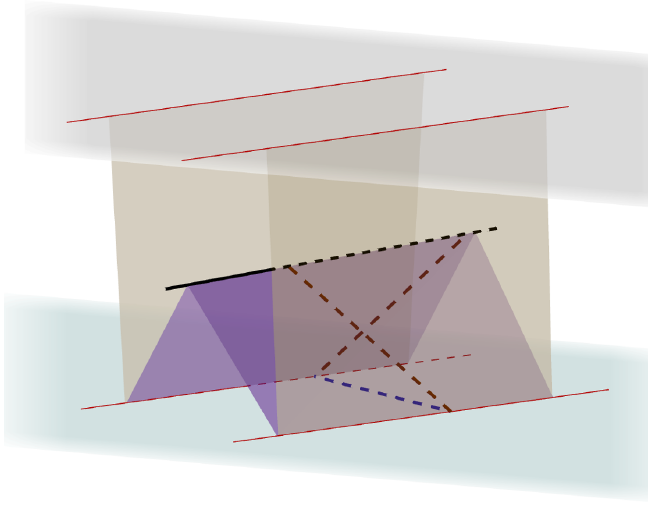
Figure 9 . The relative location of the pre-entanglement wedge W E [ A ] (bounded by two purple surfaces) and the causal wedge W [ A ] (bounded by two yellow surfaces) for (blue) single boundary C interval in planar BTZ spacetime. Two red lines on the (gray) black hole horizon are the intersection of the horizon and the yellow surfaces. Obviously the causal wedge W entanglement wedge W [ A ] in AdS E 3